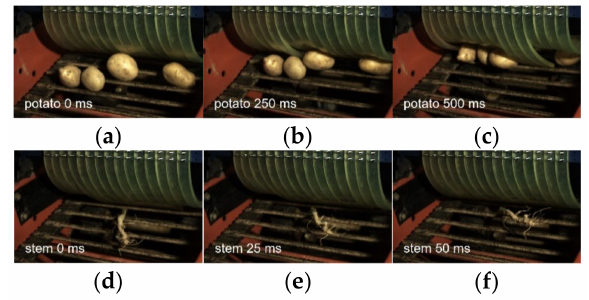
Figure 5. High-speed photographic images of potatoes and stems passing through the potato stem transported-posture adjustment mechanism. ( a – c ) Images of potatoes in contact with the stem posture adjustment mechanism for 0 ms, 250 ms and 500 ms. ( d – f ) Images of stems in contact with the stem posture adjustment mechanism for 0 ms, 25 ms and 50